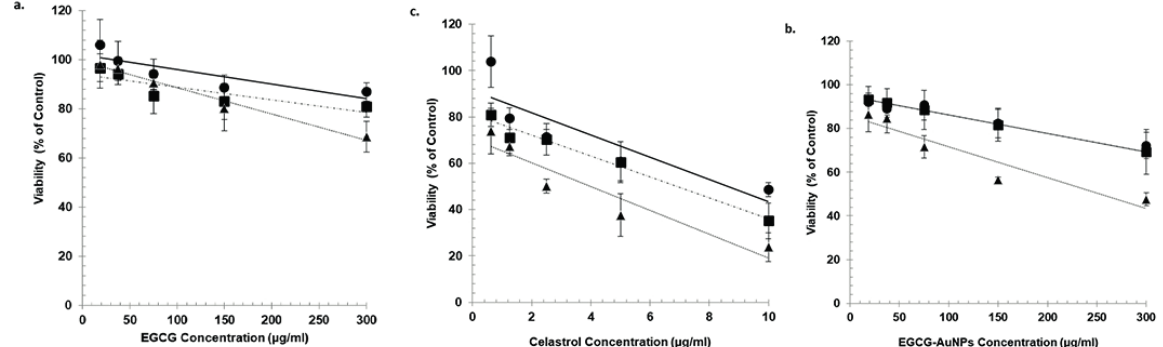
Figure 2. Viability of HepG2 Cells was assessed by MTT assay, after being treated for 24 h (circles), 48 h (squares), and 72 h (triangles) with EGCG ( a ), EGCG-AuNPs ( b ) and celastrol ( c ). Viability is expressed as the percentage of untreated control and presented as the mean ± SD of three independent experiments.